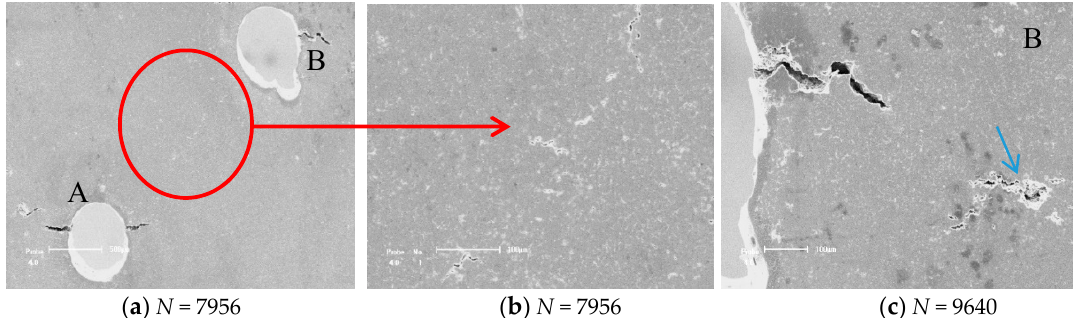
Figure 4. Fatigue crack initiation and propagation behavior of cast AM60B alloy with tilted 45° and hole distance 2.0 mm (4D) at the maximum stress level of 120MPa, R = 0.1, N f = 61562. ( a ) N = 7956, ( b ) N = 7956, ( c ) N = 9640.